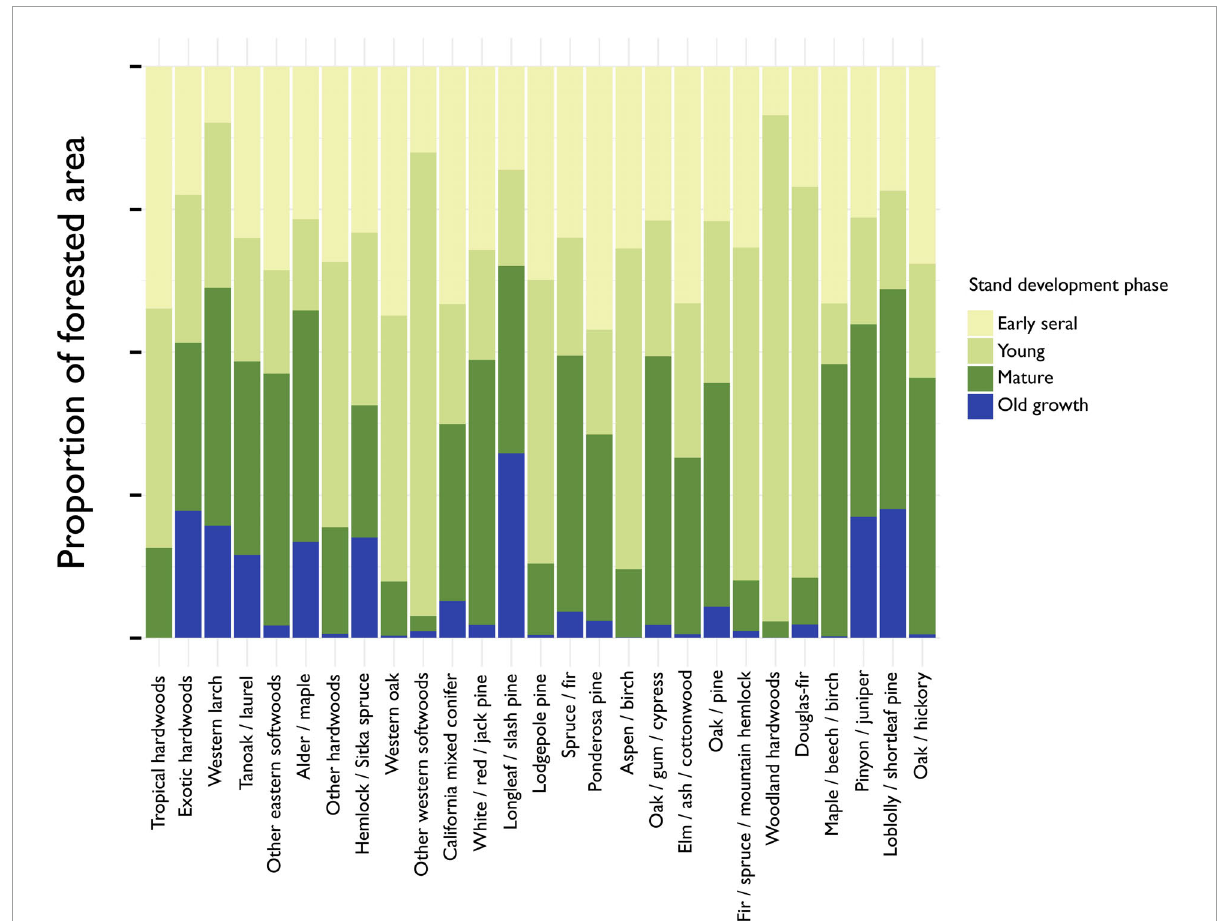
FIGURE4 The proportion of total forested area by forest type-group and stand development phase. Forested area is estimated using standard, post-stratification estimators developed by the Forest Inventory and Analysis program. Forest type-groups are ordered along the x-axis in terms of increasing forest